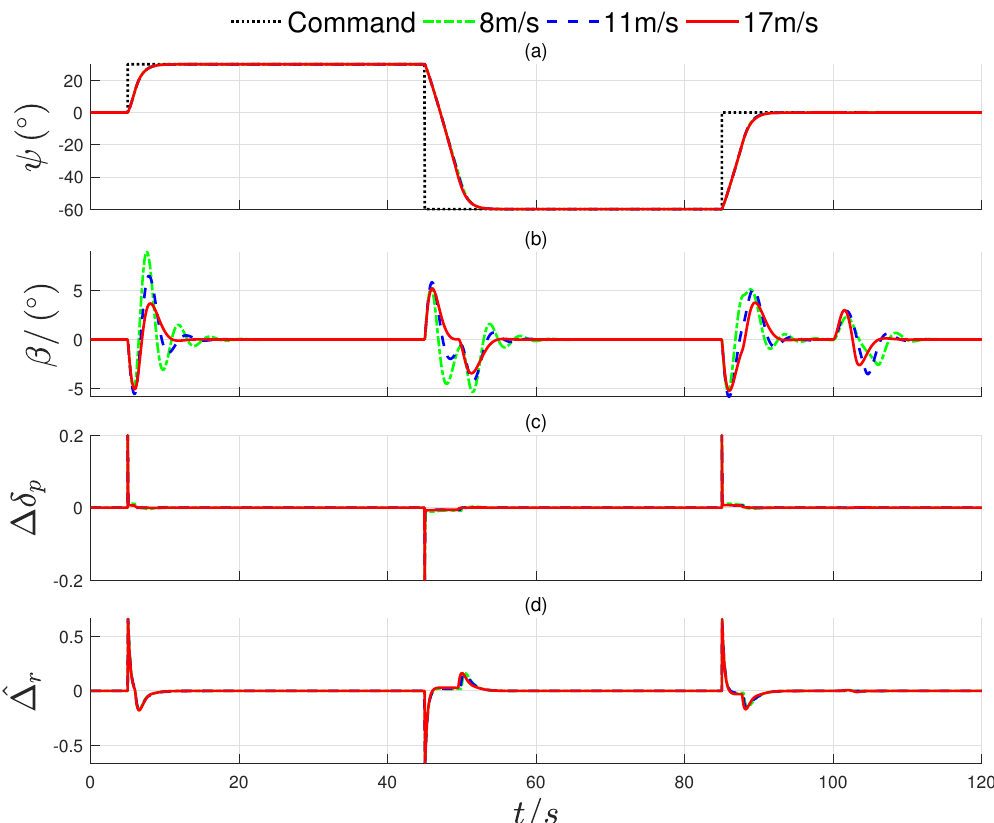
Figure 9. The yaw angle ( a ), side-slip angle ( b ), differential propeller thrust ( c ) and observer ( d ) curves of the nonlinear dynamic inversion and active disturbance rejection control (NDI-ADRC) yaw angle controller when tracking the command at different